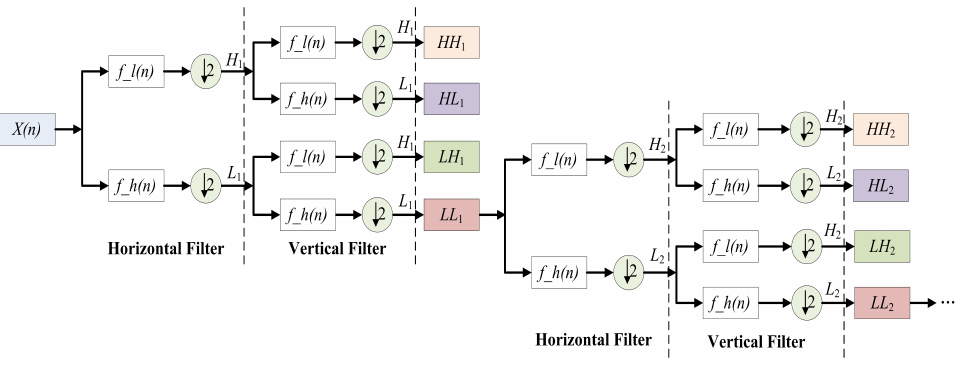
Figure 7. Decomposition process of DWT.